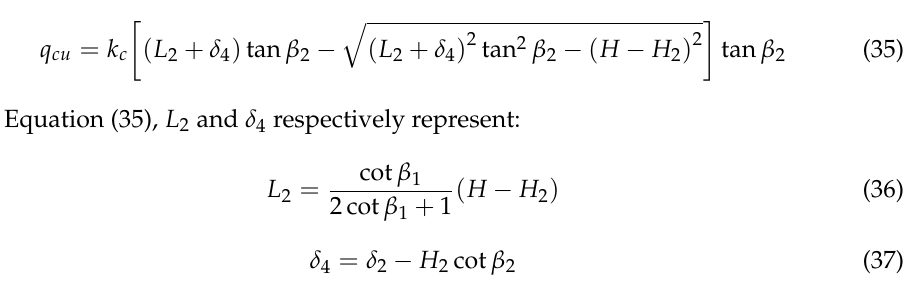
Figure 14. The gray part of the longitudinal section is between the upstream water level and the downstream water level, and the blue part is below the downstream level. The core can be divided into six parts for convenience of calculation.